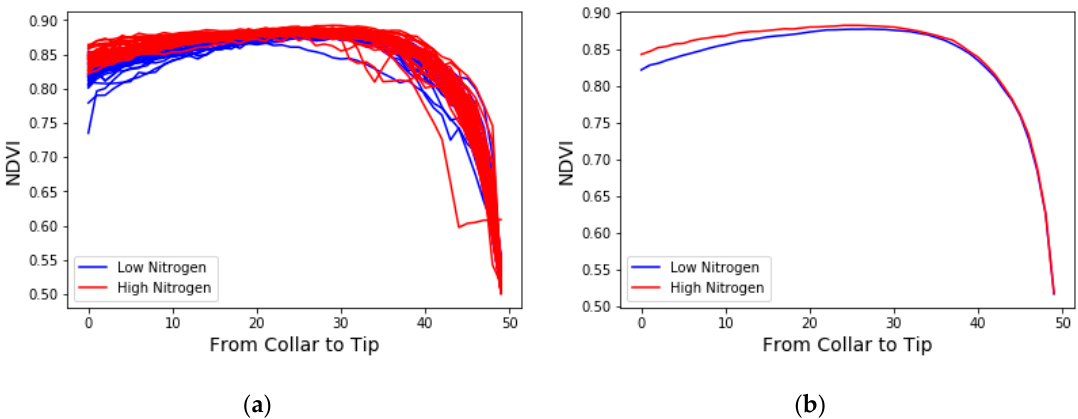
Figure 4. The average NDVI value of each scanning line along the leaf under two nitrogen treatments at the V8 stage. The X coordinate is the rescaled leaf from the leaf collar (0) to the leaf tip (50). ( a ) All 64 corn leaf samples for genotype B73xMo17; ( b ) The average of each nitrogen-stressed group. Red indicates the high nitrogen group, and blue indicates the low nitrogen group.